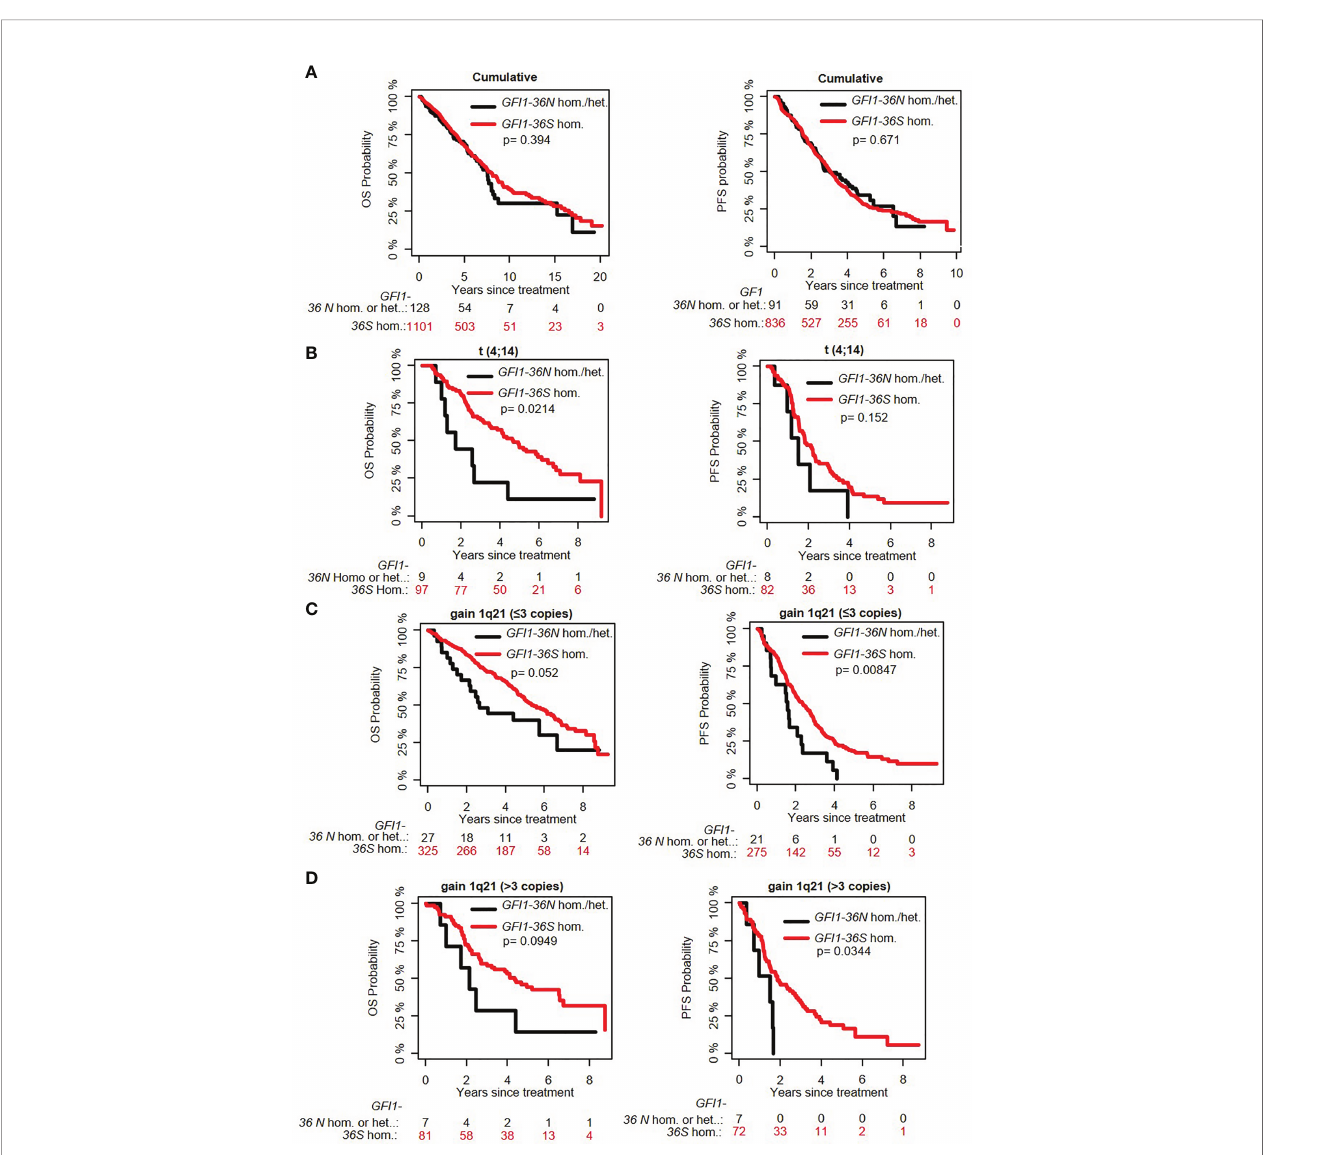
FIGURE 1 | In fl uence of the presence of GFI1-36N allele on PFS and OS of MM patient subgroups. (A) GFI1-36N did not in fl uence OS and PFS in the entire cohort. (B) GFI1-36N negatively affects OS but not PFS in MM patients with t(4;14) translocation. (C, D) GFI1-36N negatively affects OS and PFS in MM patients with gain of 1q21 ( ≤ 3 copies and >3